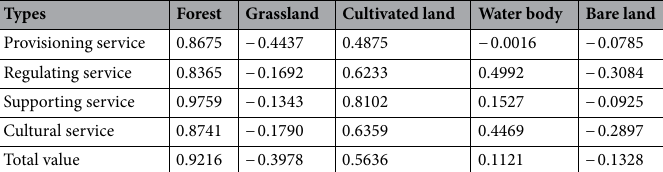
Table 9. The impact of LUCC on the ecosystem service value